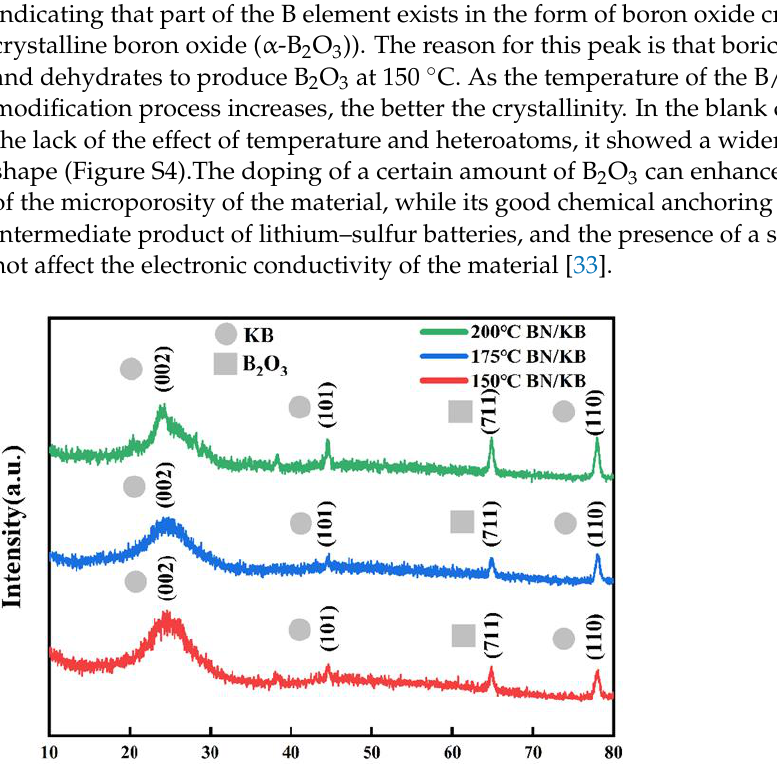
Figure 6. Illustrations of the anchoring effect of BN-reconfigured polarized surfaces on polysulfide species.